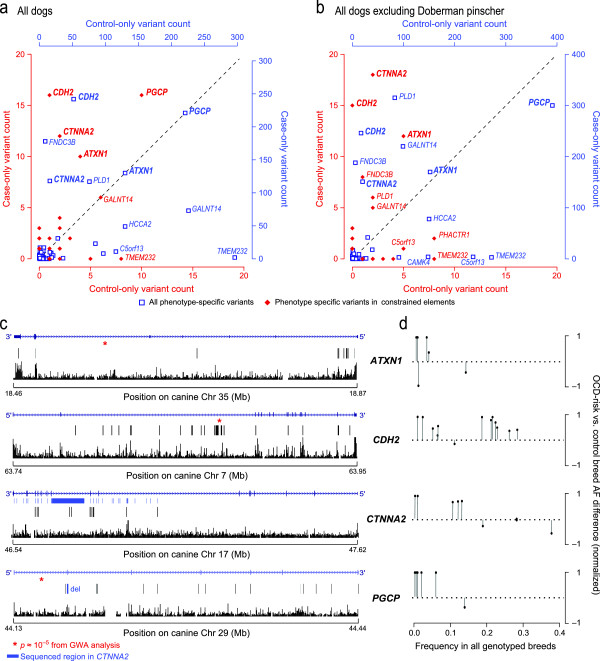
Gene-based analysis identifies four top genes enriched for case-only variants in constrained regions. (a) Genes are plotted according to the number of case-only (y-axis) and control-only (x-axis) variants within a gene and its 5 kb flanking regions from our sequence data. Blue squares denote all the variants and the corresponding axes are shown in blue; red diamonds denote variants in constrained elements only and the corresponding axes are shown in red. Genes that are plotted above the identity line harbor more case-only than control-only variants. (b) A similar analysis excluding DP, the breed used to identify genes for sequencing, shows that the enrichment pattern persists for several genes. (c) The case-only variants in constrained elements, when plotted with gene structure and evolutionary conservation, show clustering in ATXN1 (5’ end). Dimmed bars represent canine variants that failed to lift over onto hg19. The conservation track shows a measure of evolutionary conservation in dog, human, mouse and rat [29]. (d) In each gene, SNPs with the greatest risk allele frequency (AF) difference between OCD-risk and control breeds (y-axis) tend to have lower frequency across all genotyped breeds (y-axis). SNPs are shown as solid circles with vertical lines.